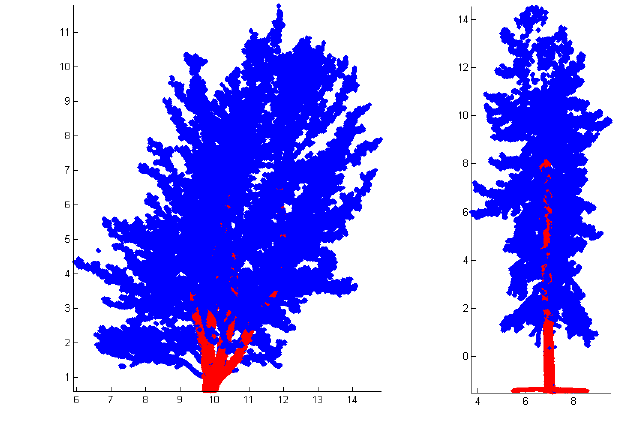
Figure 7: Classification of branch